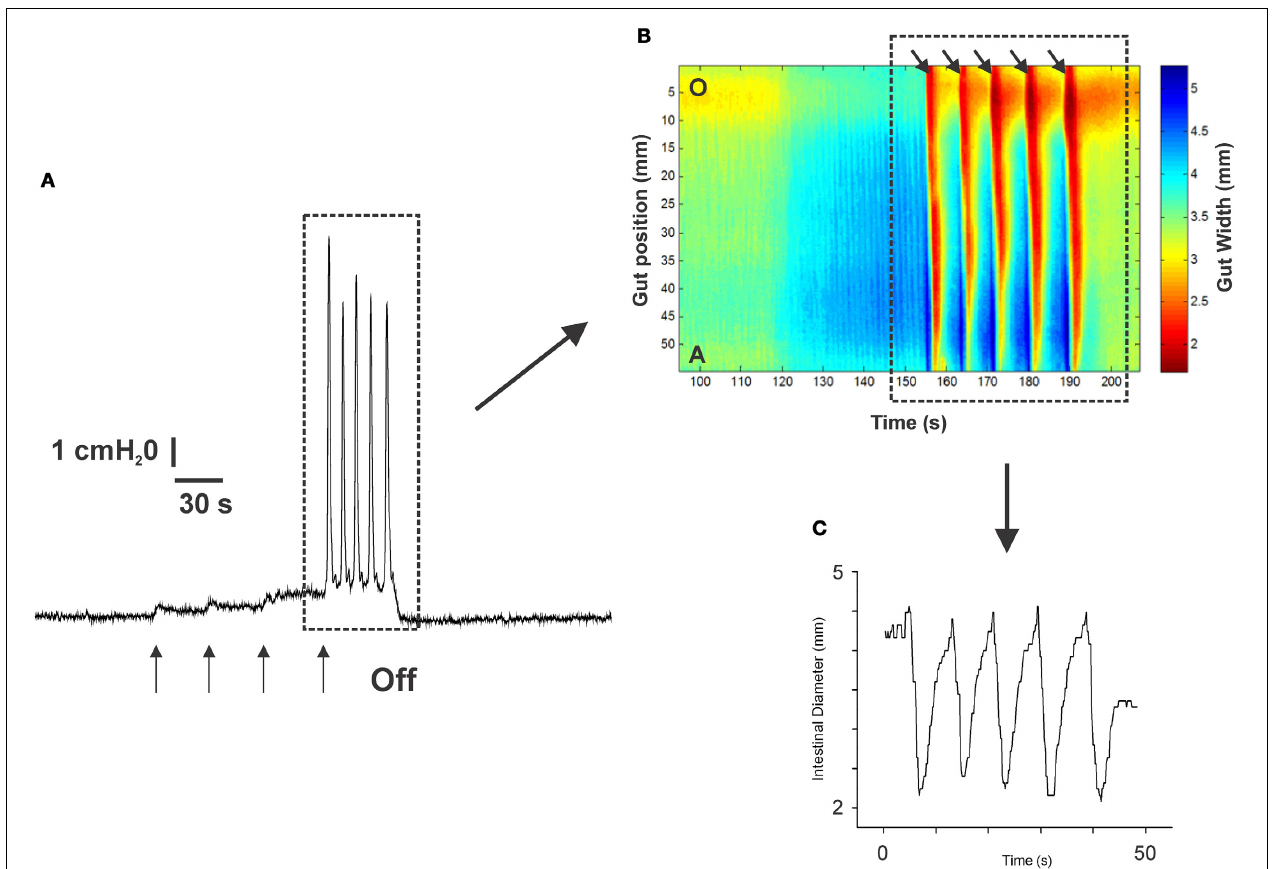
FIGURE 1 | The propulsive motor pattern (peristalsis) in an isolated segment of guinea-pig ileum. The segment was distended in cumulative 1cm H 2 O steps by raising the lumenal perfusion reservoir, which caused phasic increases in intraluminal pressure (A) . (B) The corresponding spatio-temporal map of the propulsive contractions (black arrows) recorded at